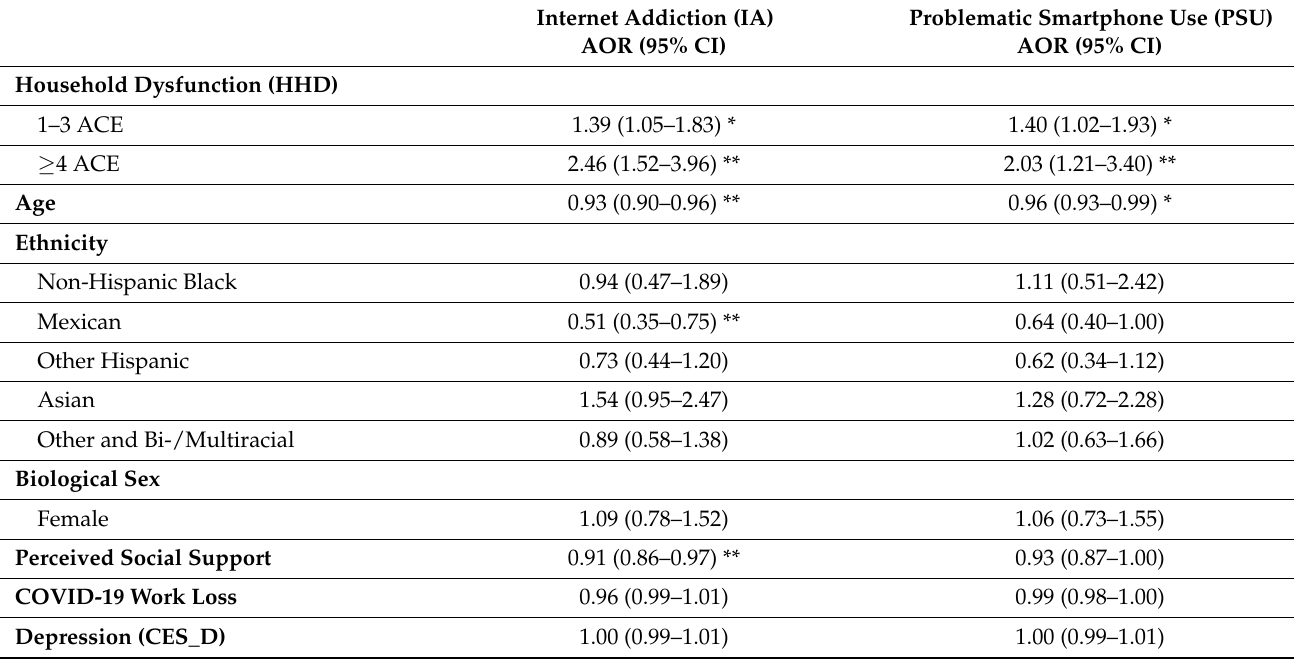
Table 3. Association between household dysfunction (HHD) and problematic Internet and smartphone use ( N = 1027).